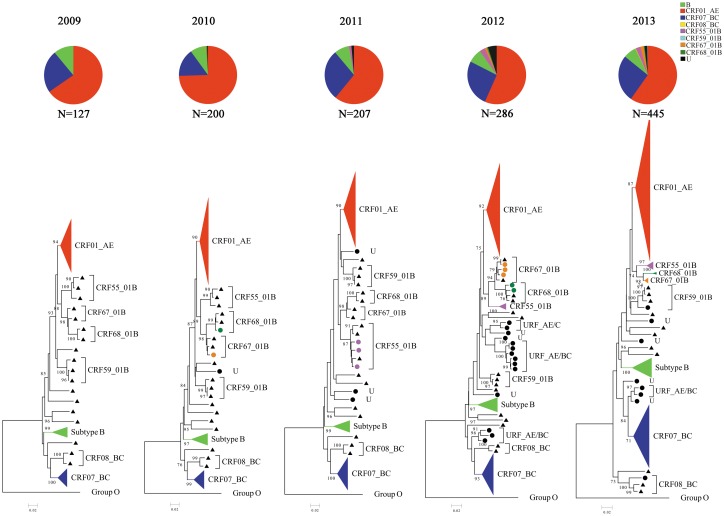
Phylogenetic tree analysis based on HIV-1 pol region among MSM who were newly infected from 2009 to 2013 in Shanghai.The phylogenetic trees were constructed using the Neighbor-Joining method. The bootstrap values of 1000 replicates above 70% are marked on the cluster nodes. CRF01_AE sequence cluster is shown as a triangle in red, CRF07_BC cluster in blue, subtype B cluster in green, and CRF55_01B cluster in pink. U, ambiguous/unidentified subtypes or recombinants and is marked as a solid circle in black. The reference sequences obtained from the Los Alamos HIV database are marked as a solid triangle in black. Trees were rooted by group O. The pie figures presented the proportion of analyzed subtypes represented in the corresponding phylogenetic trees.